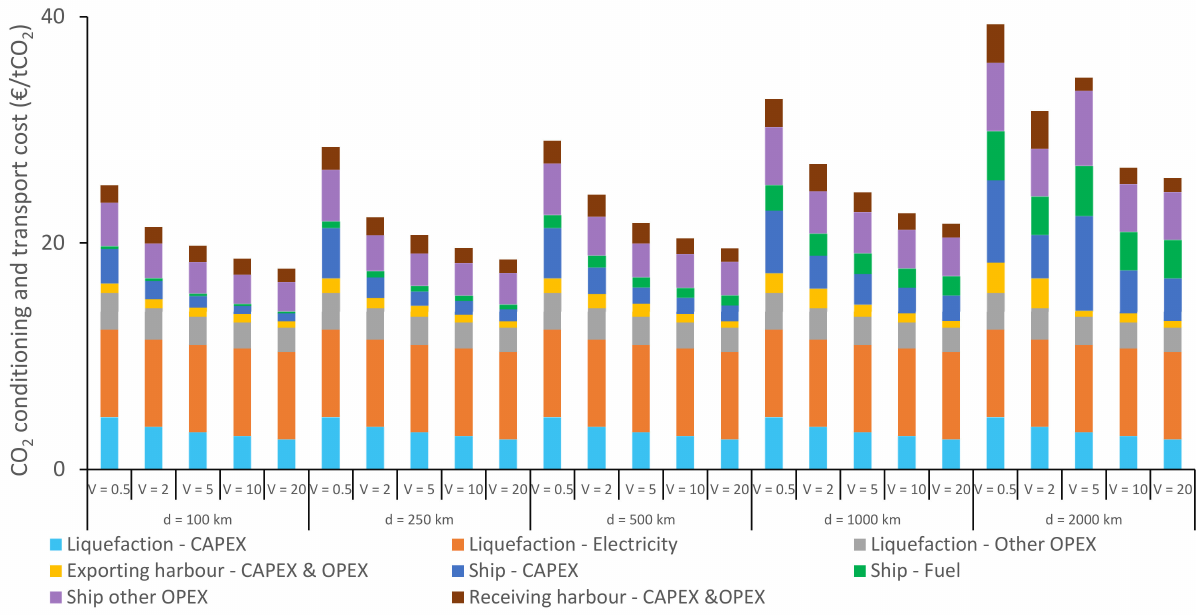
Figure A9. Cost breakdown of CO 2 conditioning and transport costs as a function of transport distance (d in km) and annual volume (V in MtCO 2 /year) when transporting pure CO 2 between two harbours by ship at 7